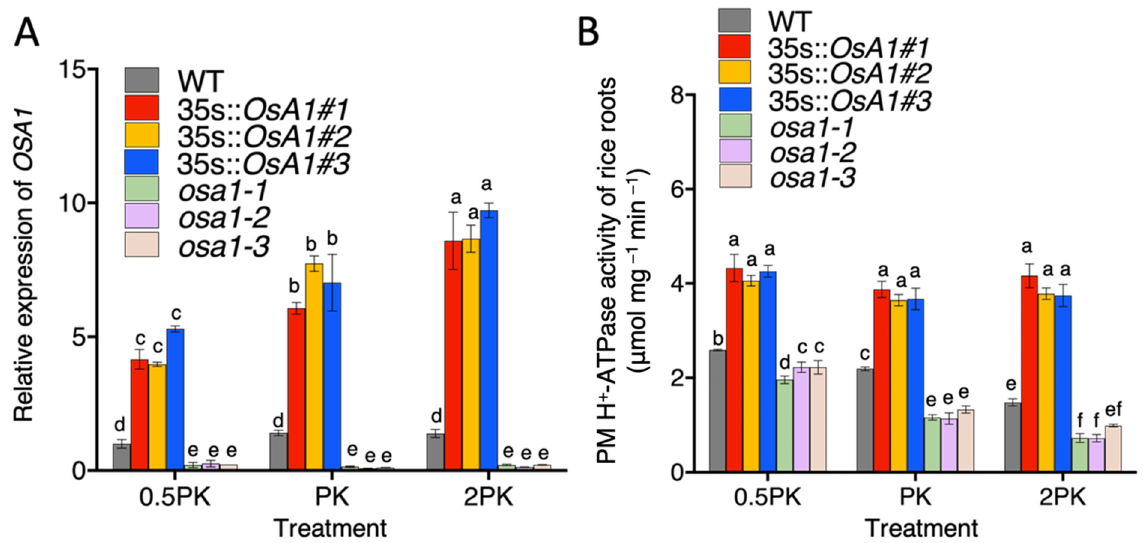
Figure 2. OSA1 expression level and PM H + -ATPase activity in WT, OSA1 -oxs, and osa1 mutants under different concentrations of P and K (0.5PK, PK, and 2PK). ( A ) Relative expression of OSA1 in WT and OSA1 transgenic plants roots. Values indicate means ± SD ( n = 3). ( B ) Hydrolytic activity of PM H + -ATPase in roots of OSA1 -oxs and osa1 mutants. Different letters indicate significant differences at p < 0.05 according to two-way ANOVA with Tukey’s multiple-comparisons test.